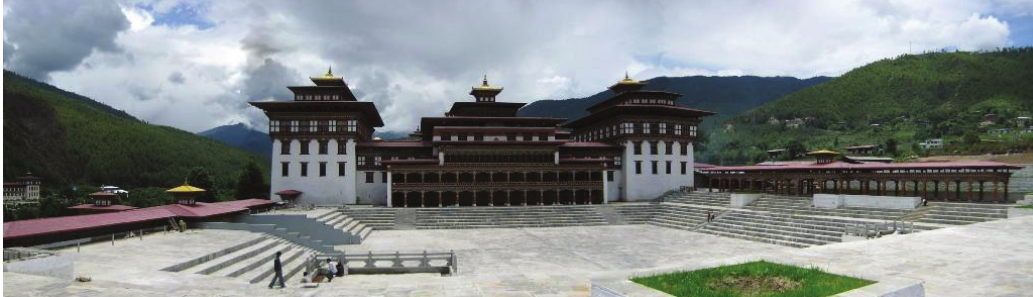
Figure 6. Tshechu Ground or the National Ceremonial Plaza in Thimphu,